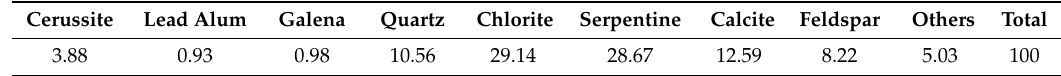
Table 3. Mineralogical composition of raw ore / %.